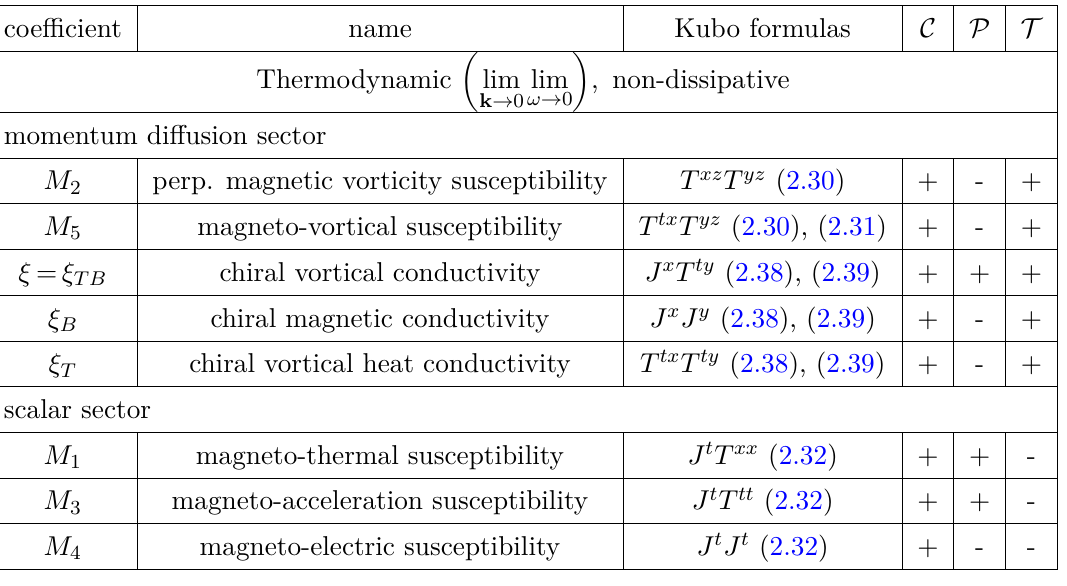
Table 3 . Independent thermodynamic transport coefficients in a charged chiral thermal plasma subjected to a strong U(1) magnetic field. The column “Kubo formulas” points to the equations A containing the relevant Kubo formulas. In that column, the operator combinations, e.g. J x T ty indicate the correlation function appearing in the Kubo formula for the spatial momentum to be aligned with the magnetic field. The susceptibilities χ , χ , χ and χ are not counted here 11 13 33 B as transport coefficients because they are thermodynamic derivatives of pressure. Here, “perp.” denotes